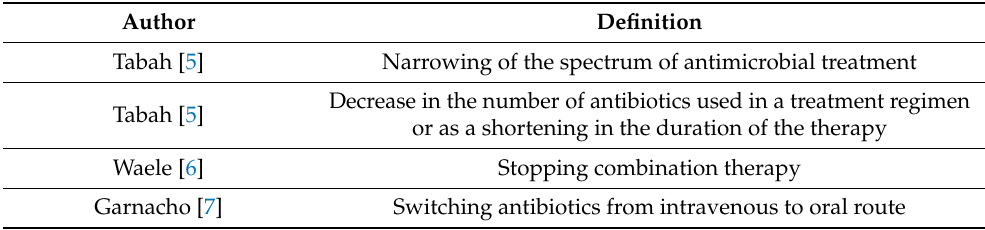
Table 1. Definitions of antibiotic